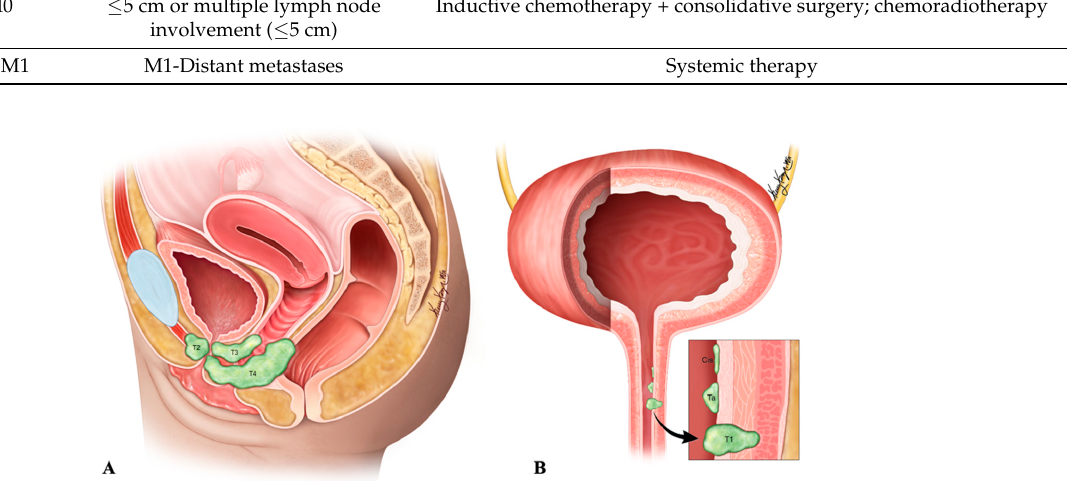
Figure 16. Staging of urethral neuroendocrine carcinoma. ( A ) Sagittal view of the tumor spread ( B ) Urethral site specific tumor spread. Ta: non-invasive papillary, polypoid, or verrucous carcinoma; Cis: carcinoma in situ; T1: tumor invasion into subepithelial connective tissue; T2: tumor invasion into periurethral muscles; T3: tumor invasion into anterior vagina or bladder neck; T4: tumor inva- sion into adjacent organs such as the bladder and rectum.